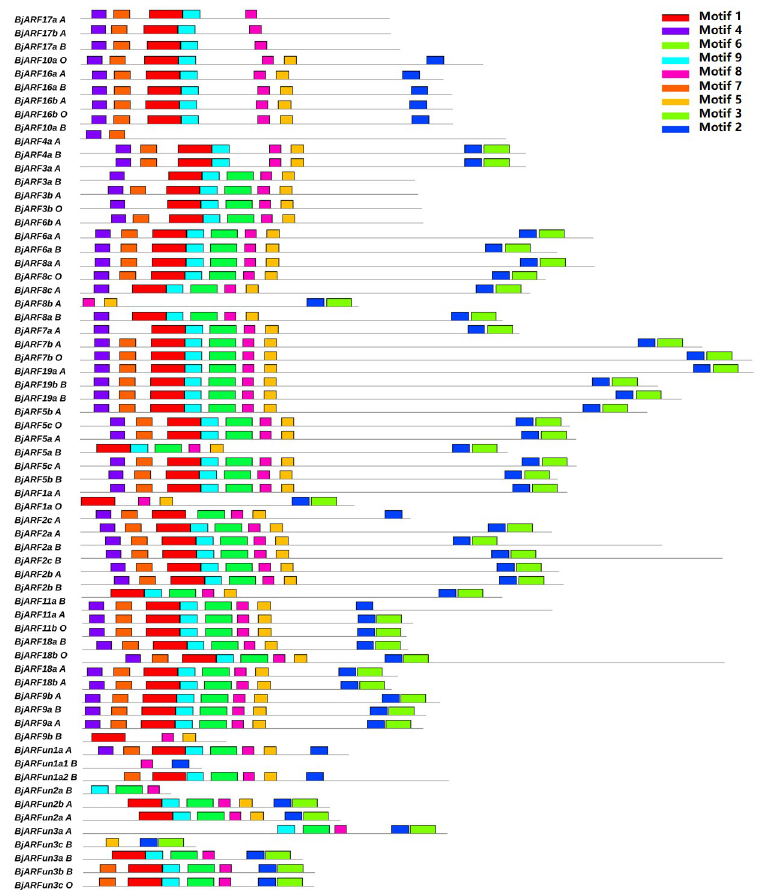
Fig 4. Conserved motifs of BjARF proteins identified in this study. The conserved motifs were identified using MEME (suite 4.11.4) based on BjARF protein sequences, and each motif is indicated with a colored box numbered 1 to 9 at the upper right